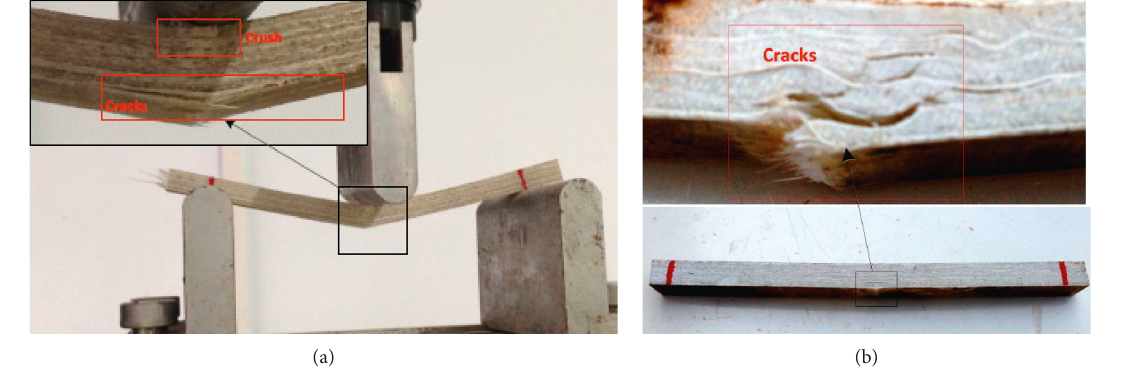
Figure 4: Failure modes. (a) Longitudinal. (b)